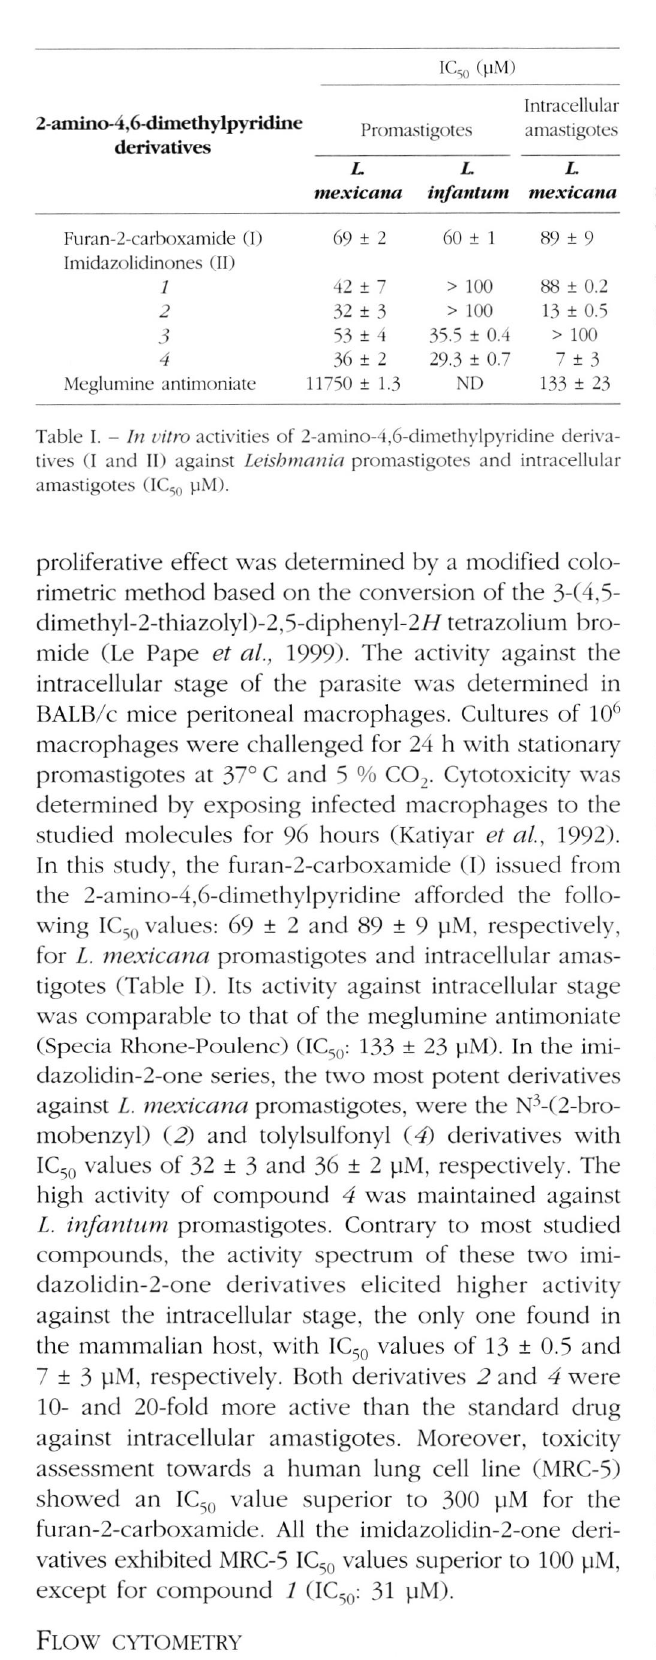
Table I. - In vitro activities of 2-amino-4,6-dimethylpyridine deriva­ tives (I and II) against Leishmania promastigotes and intracellular amastigotes (IC, pM). 0